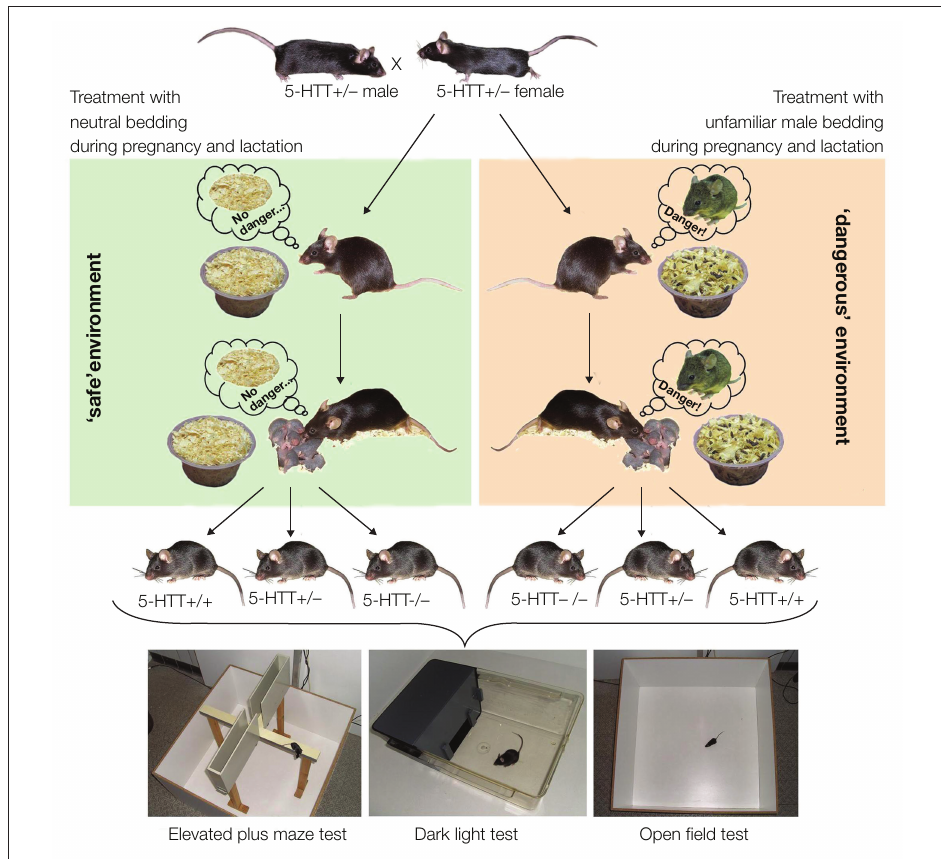
Figure 1 | Simulation of a ’ dangerous environment ’ and subsequent behavioral testing of the offspring. Heterozygous 5-HTT knockout females were mated with 5-HTT + / − males. During pregnancy and lactation dams were repeatedly exposed to olfactory cues of unfamiliar adult males by introducing small amounts of male-soiled bedding to their home cage (‘dangerous environment’). The odor cues of strange males signal the threat of infant killing and thus create a ‘dangerous environment‘ for the mother and her pups. Offspring varying in genotype (5-HTT + / + , + / − , and − / − ) were tested for their anxiety-related and exploratory behavior in the Elevated Plus Maze test, Dark Light test, and Open Field test in